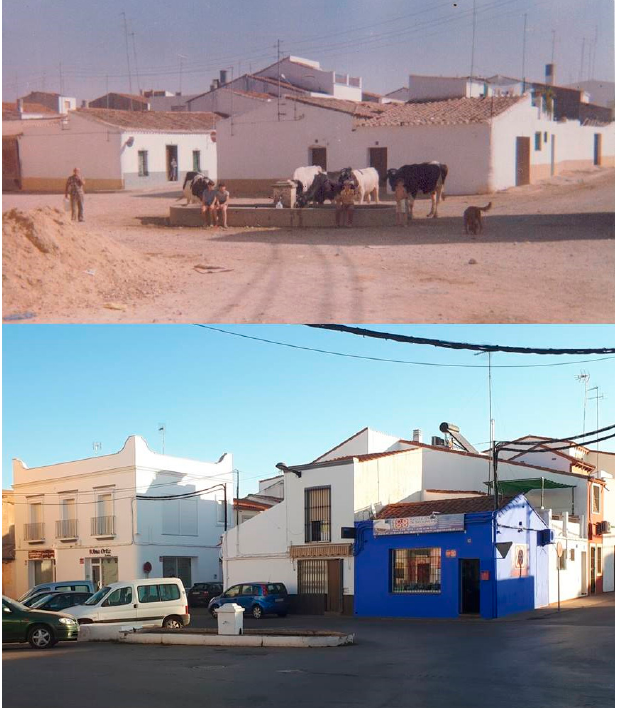
Figure 1. “La bomba”, in 1985 and nowadays. Old troughs and houses, Fuente del Maestre, Spain (Photo: Manuel García).